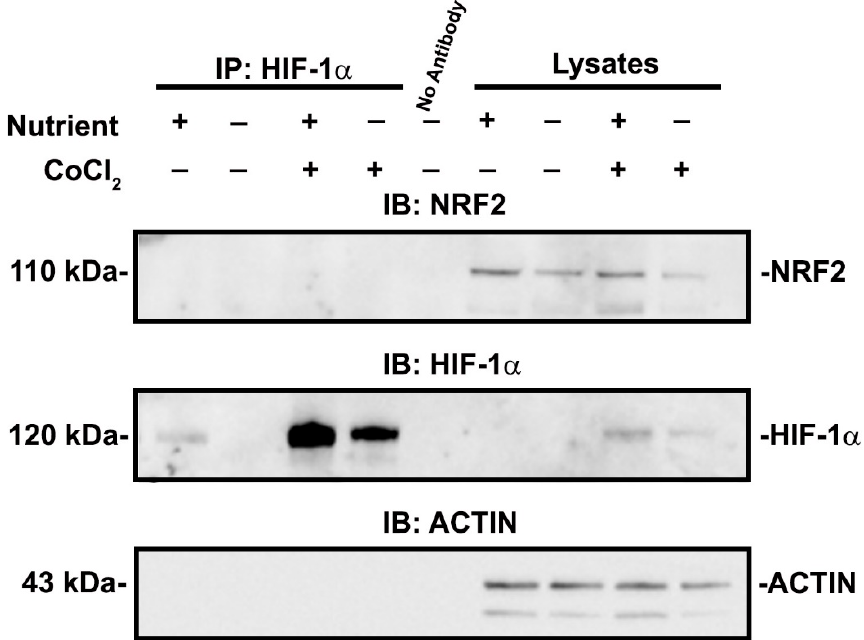
Figure 8. HIF-1 α and NRF2 do not directly interact in cells exposed to experimental conditions. HIF- 1 α is immunoprecipitated and immunoblots for NRF2 and HIF-1 α were performed after exposure to replete or deficient conditions in the presence or absence of 200 µ M CoCl 2 . In all cell culture conditions, there was no indication of co-immunoprecipitation of HIF-1 α and NRF2. Cell lysates without immunoprecipitation are shown as a control.